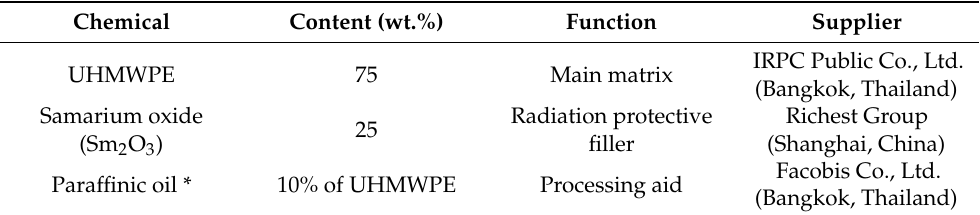
Table 2. Material formulations of UHMWPE composites and their chemicals, roles, and suppliers. Chemical Content (wt.%) Function Supplier UHMWPE 75 Main matrix